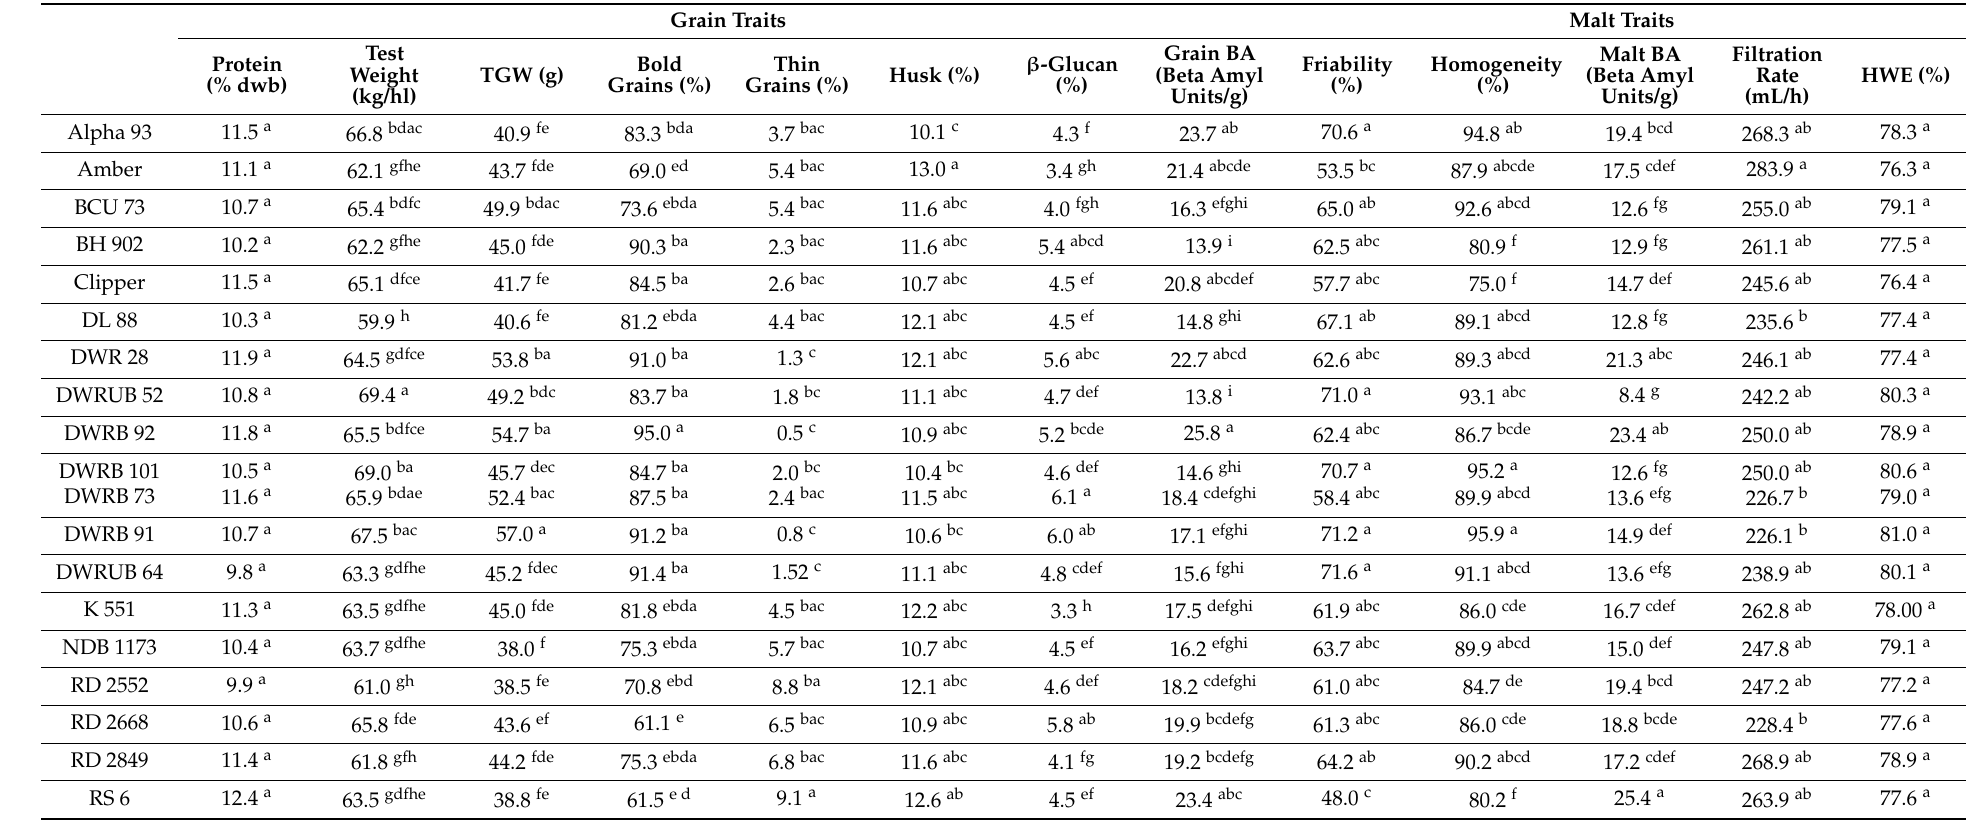
Table 2. Grain and malt quality traits of different barley